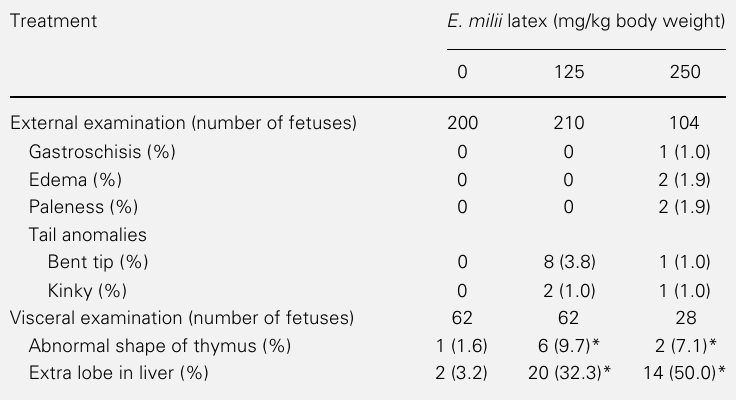
Table 4 - Occurrence of externally visible and visceral abnormalities in fetuses of rats treated orally with E. milii latex (0, 125 and 250 mg/kg body weight) on days 6 to 15 of